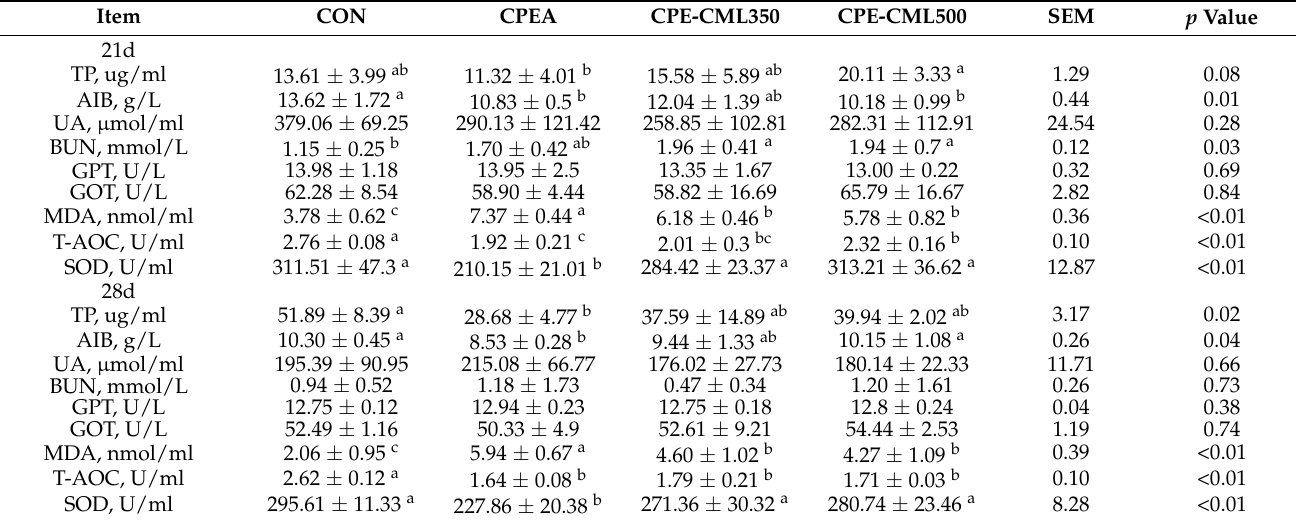
Table 6. Serum biochemical